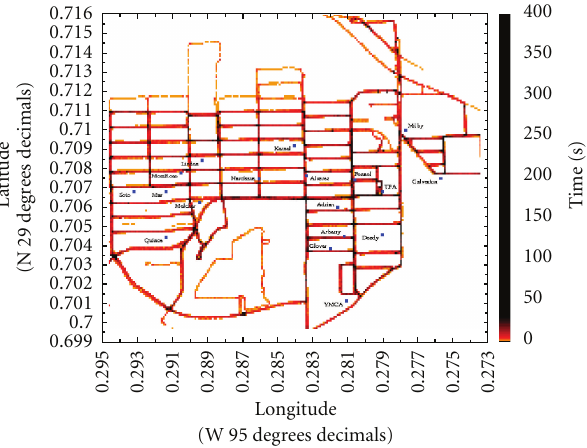
Figure 5: TFA-Wireless Network measurements in Houston,